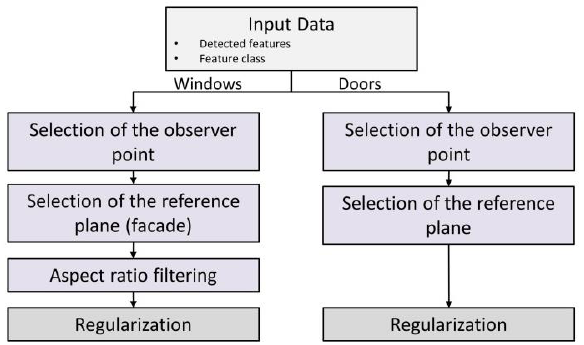
Figure 3. Workflow of ray-tracing algorithm adopted for the detection of